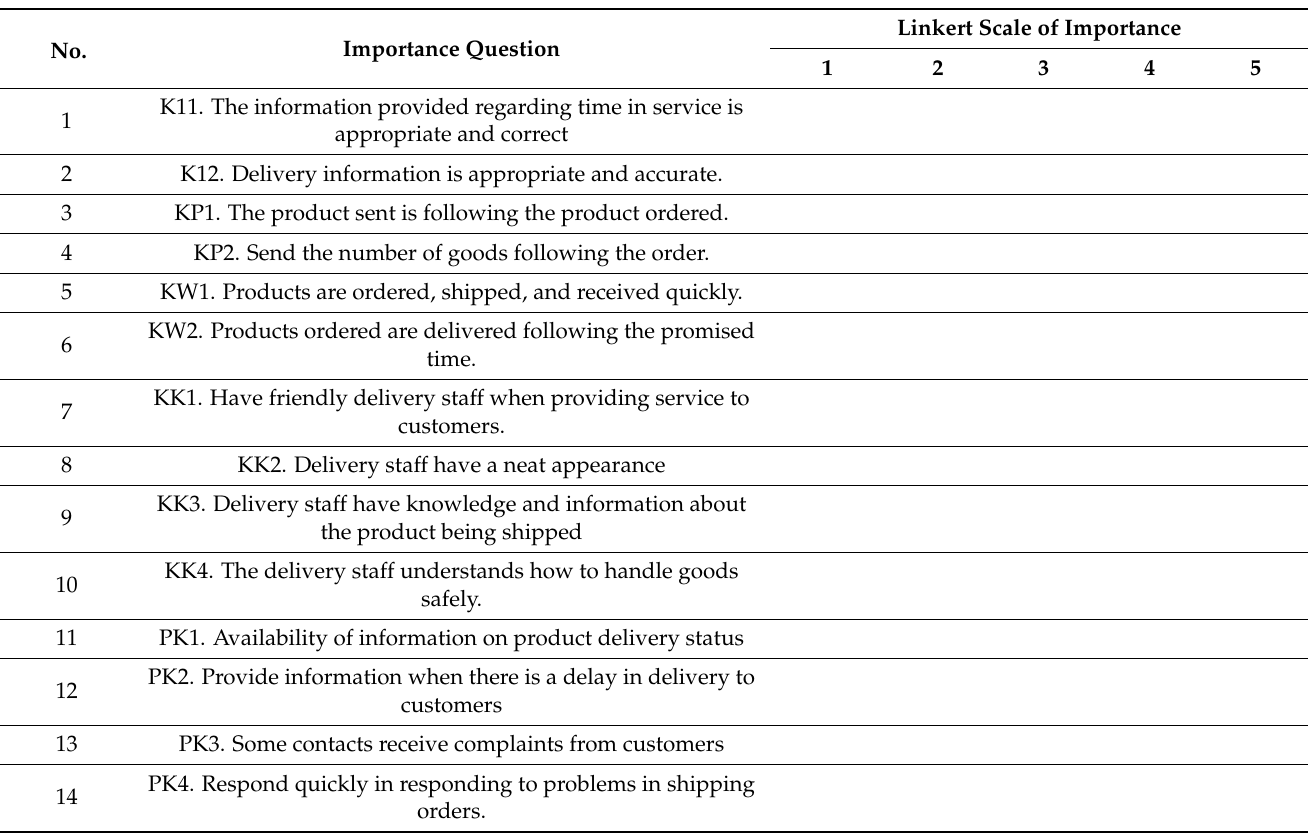
Table A1. SIPA & Modified Kano